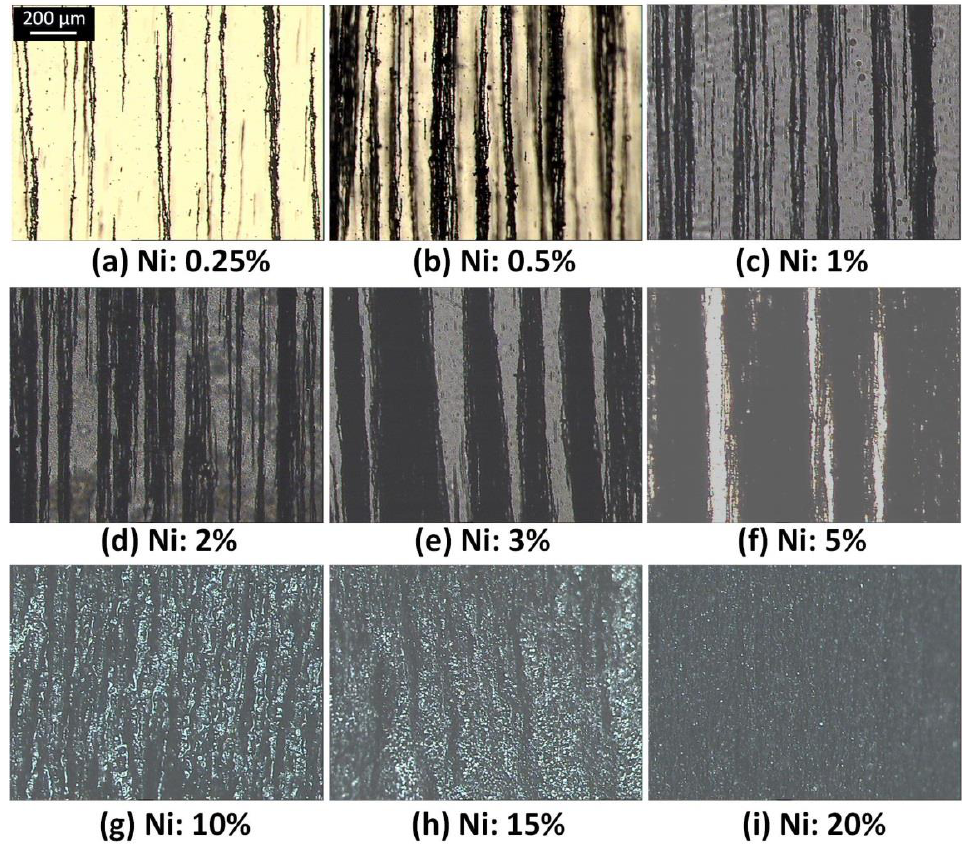
Figure 4. Distribution morphology of nickel particles in Shape Memory Polymer (SMP) matrix under the magnetic field in horizontal plane.